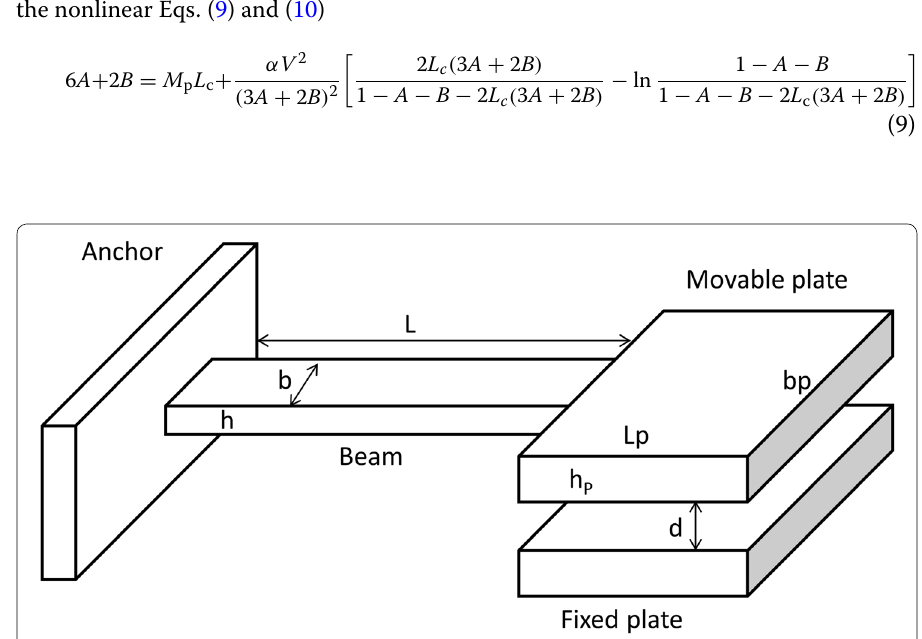
Fig. 1 The schematic of the parallel plate